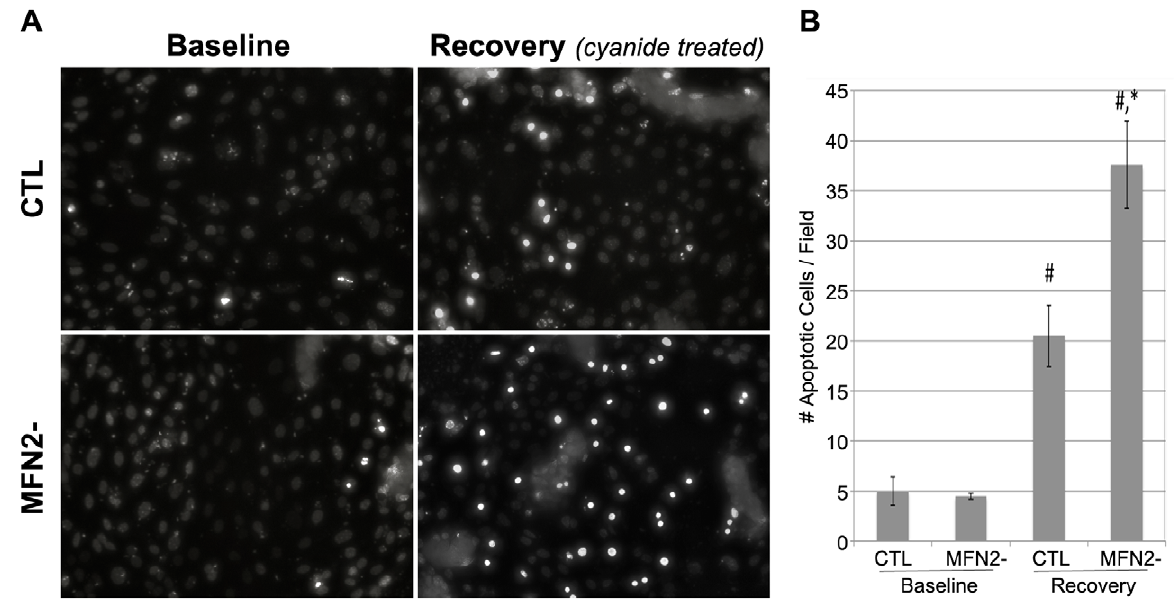
Figure 6. Effect of MFN2 deficiency on apoptosis after metabolic stress. ( A ) Wide field fluorescent microscopy of Cre (MFN2-) and empty (CTL) adenovirus transduced cells stained with Hoechst dye after 3 hr ATP depletion induced by cyanide exposure in glucose free medium followed by and 6 hr recovery in complete medium; apoptotic cells are brightly stained, small and round. ( B ) Quantitative analysis of apoptotic cell number in five randomly selected fields under each experimental condition; # P , 0.05 vs. EV/Base or CRE/Base, respectively; * P , 0.05 vs. EV/Rec. Data represent the mean and SE of at least 3 separate experiments.